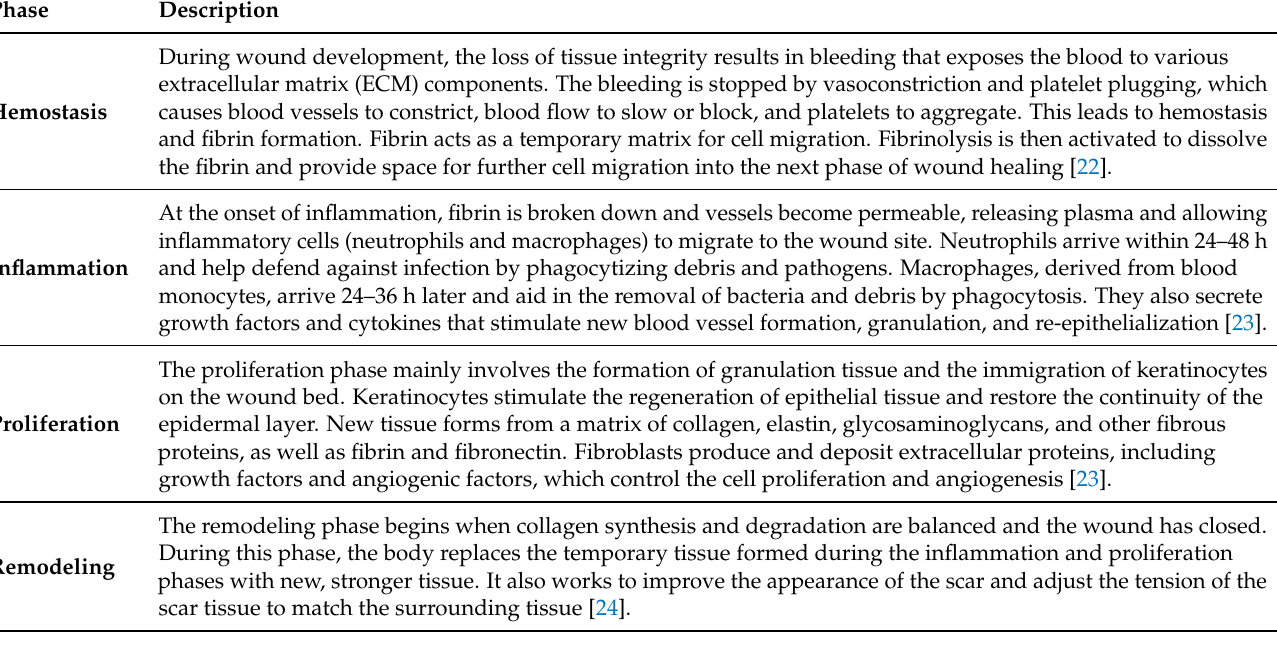
Table 1. Four phases of wound healing.